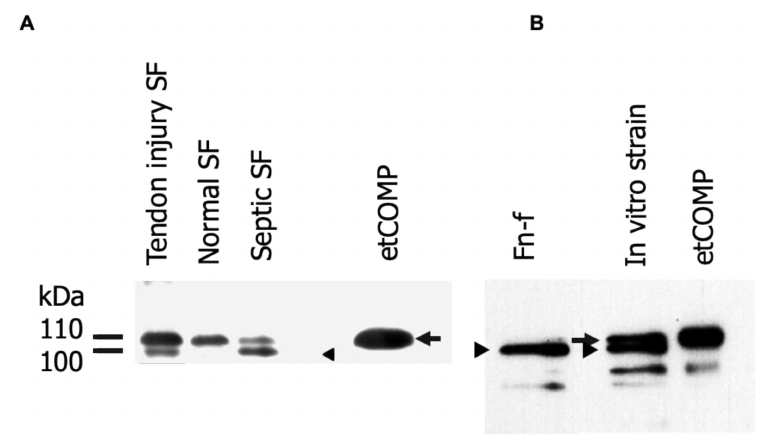
Figure 1. Western blots of 4–16% SDS-PAGE gels run under reducing conditions loaded with ( A ) semi-purified fragments from synovial fluid (SF) and ( B ) culture media from in vitro tendon explants subjected to treatment with Hep II (C-terminal heparin-binding) fragment of